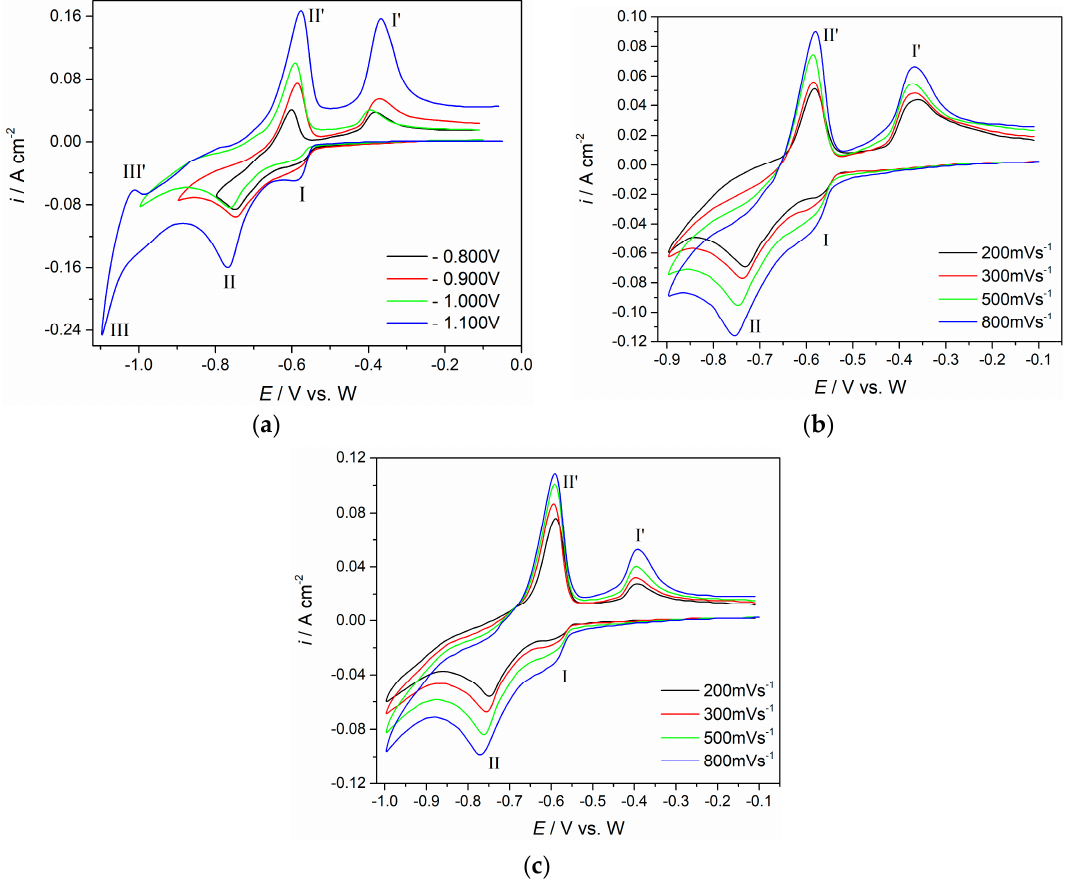
Figure 3. Cyclic voltammograms recorded on Mo working electrode in NdF 3 –LiF + (2 wt.%) Nd 2 O 3 molten salt electrolyte, at 1323 K: ( a ) v = 500 mV·s − 1 , potential range was from − 0.10 V to a different cathodic end potential; ( b ) potential range from − 0.10 V to − 0.90 V scanned with different sweep rates; ( c ) potential range from − 0.10 V to − 1.00 V scanned with different sweep rates.